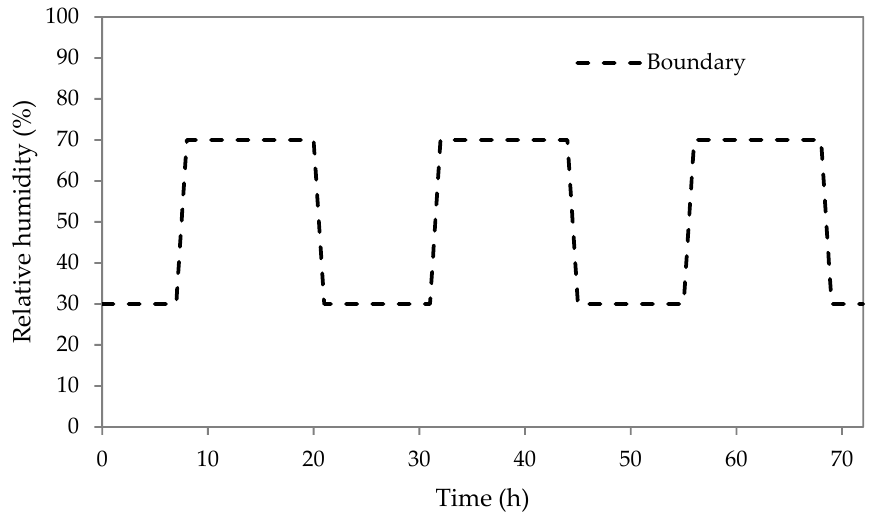
Figure 3. Time-dependent relative humidity variations during MBV experiment.